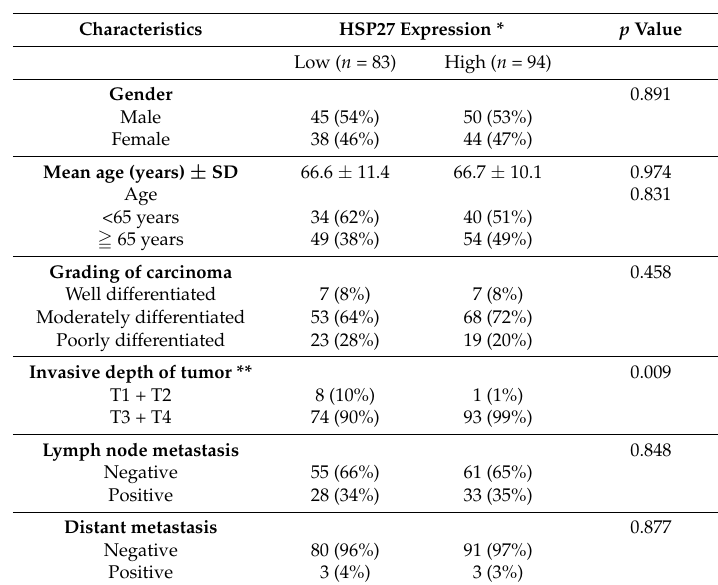
Table 2. Association between clinicopathologic characteristics and HSP27 expression in colon